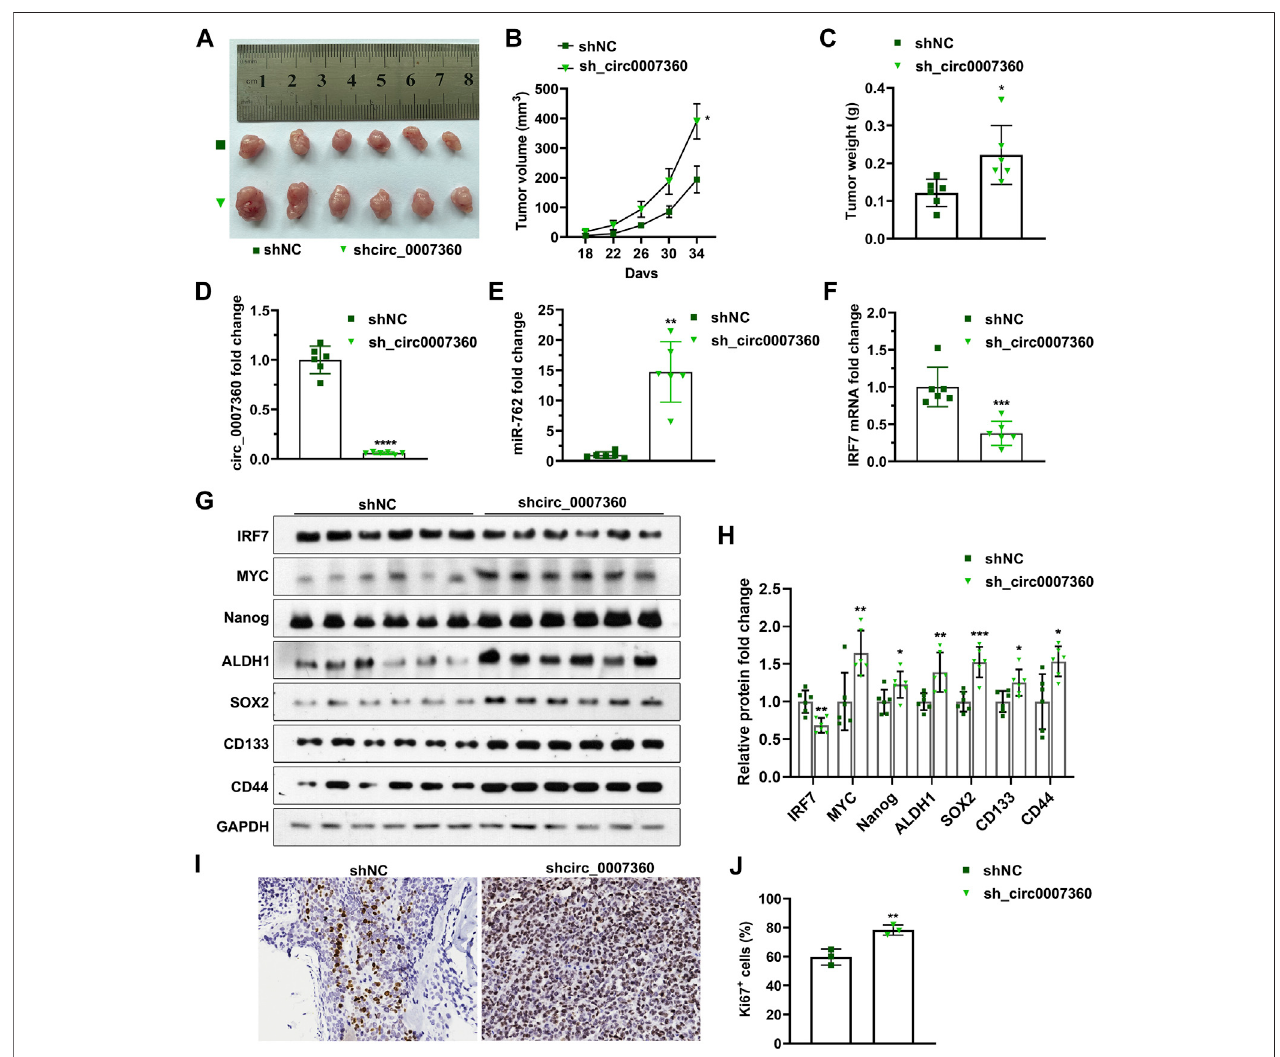
FIGURE 9 | Depletion of circ0007360 enhances gastric tumor formation in mice. (A) Representative images of tumors formed by cells with circ0007360 depletion inmice via subcutaneousinjection. (B , C) Volumeoftumors (B) andquanti fi cationoftumorweight (C) formedbyAGScellswith circ0007360 depletion via subcutaneous injection in mice. (D – F) RT-qPCR detection of circ0007360 (D) , miR-762 (E) , or IRF7 (F) RNA levels in tumors formed by AGS cells with circ0007360 depletion via subcutaneous injection in mice. (G , H) Representative images and quanti fi cation of western blotting detection of IRF7 and markers involved in cell stemness regulation. (I , J) Representative images (I) and quanti fi cation (J) of immunohistochemistry staining for Ki67 in tumors formed by cells with circ0007360 depletion.